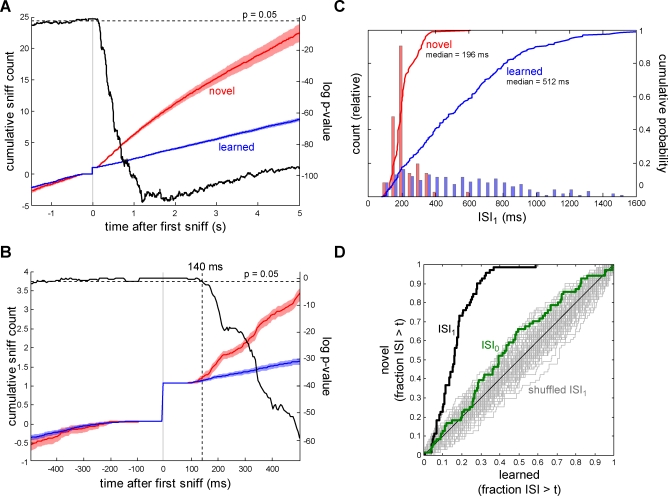
Respiration Changes Rapidly after Detection of a Novel Odorant(A) Cumulative sniff counts (left axis) for novel (red) and learned (blue) odorant presentations. Time bin is 5 ms. Solid line indicates the mean value, shaded areas indicate standard error of the mean (s.e.m.). Sniff count for each trial is set to one at the time of the first inhalation after odorant onset (time = 0). Inhalations preceding odorant onset (negative time) are counted as negative in the cumulative sniff count, to track respiration preceding odorant presentation. Black plot shows log p-value (right axis) of Student's t-test comparison of novel and learned trials.(B) Detailed view of same plots as in (A), around time of odorant detection. Vertical dashed line indicates time after which the p-value remains below 0.05 (140 ms).(C) Comparison of ISI between the first inhalation after odorant onset (i.e., the “detection sniff”) and the next inhalation (ISI1) for novel and learned trials. The two distributions differ dramatically. Time bin is 50 ms.(D) ROC curves comparing the relative distributions of ISI values between novel and learned trials, for both ISI1 (black) and for the first inhalation and the one preceding it (ISI0, green). Diagonal line represents identical distributions of novel and learned values. Gray traces indicate ROC curves for all ISI1 data randomly designated as novel or learned (100 iterations); the ISI1 curve is far above the diagonal, indicating a strong separation between the distributions. The ISI0 curve is within the range of chance indicated by the shuffled trials.